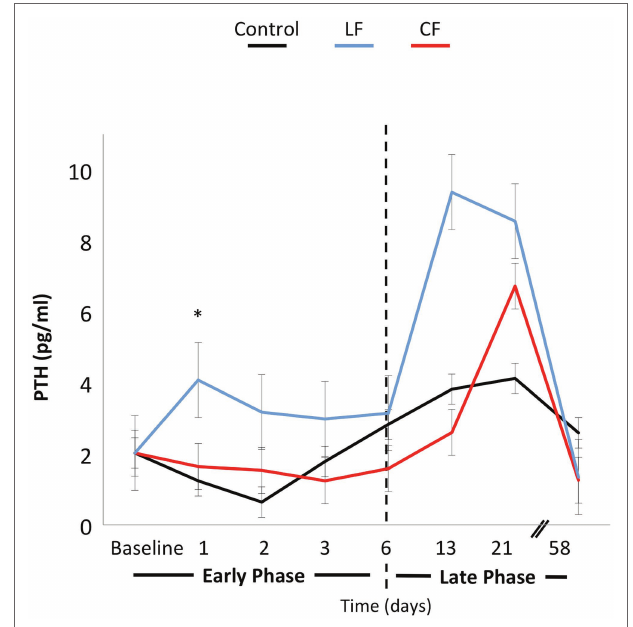
FIGURE 4 | The line graph shows the variation of PTH concentrations over time. Force application did not alter the PTH level significantly. On the first and second days, PTH concentrations were elevated in the LF group. In the late phase, differences over time or between force groups were not significantly